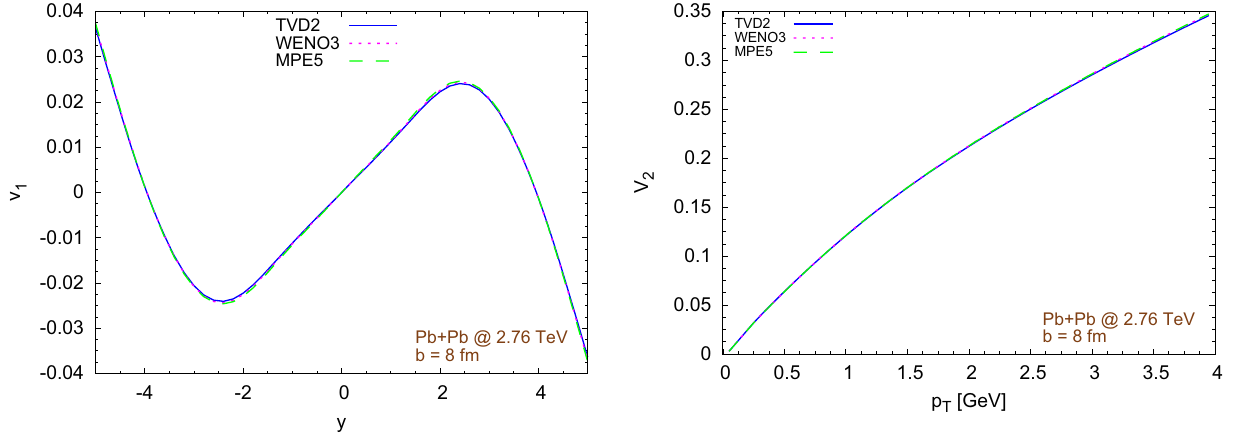
Fig. 18 Evaluation of the impact of choice of the reconstruction algo- rithm on Fourier harmonics v 1 , 2 . The figures refer to Pb+Pb collisions √ s NN = 2 . 76TeV with an impact parameter b = 8fm and without at